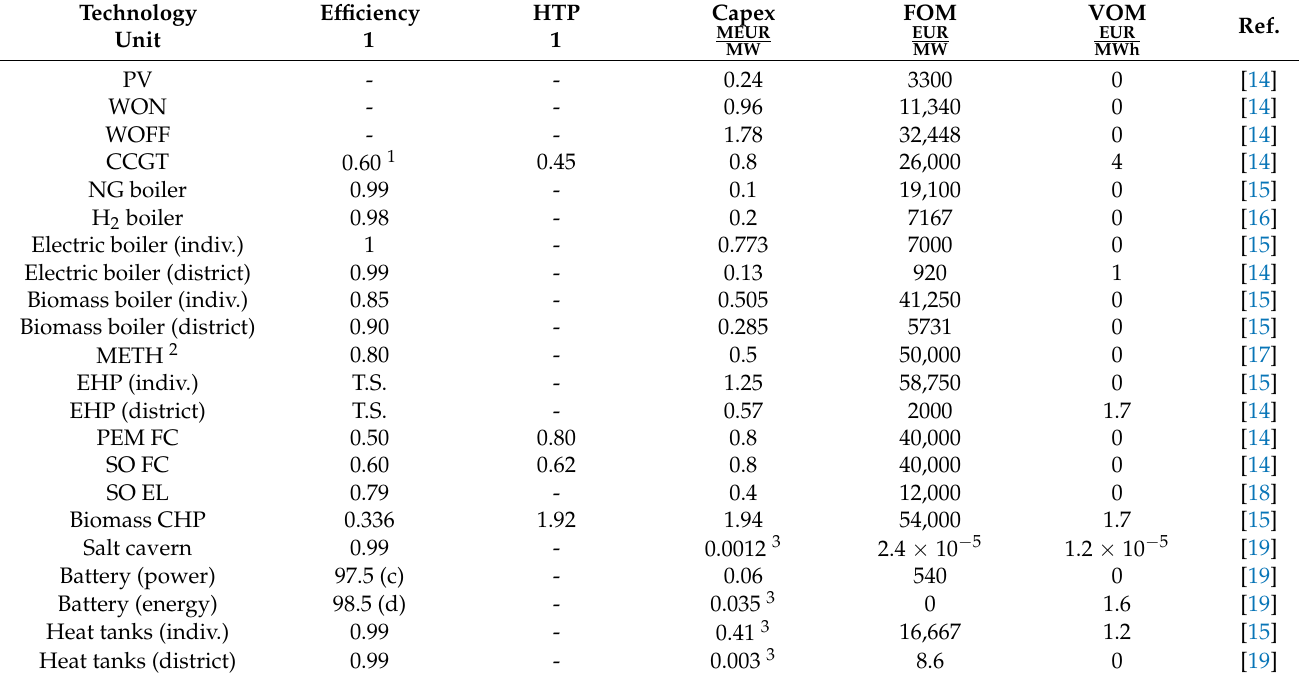
Table 1. Main techno-economic